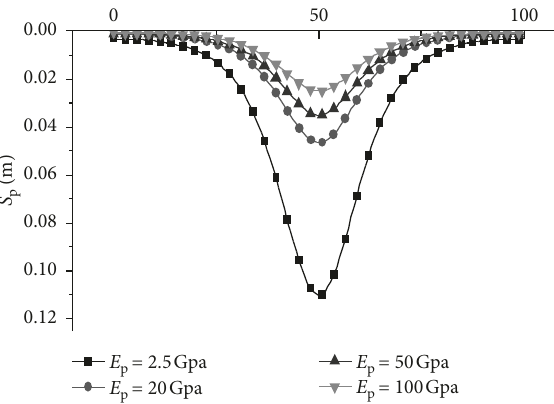
Figure 6: Transverse subsidence of pipeline in different pipeline compression moduli.